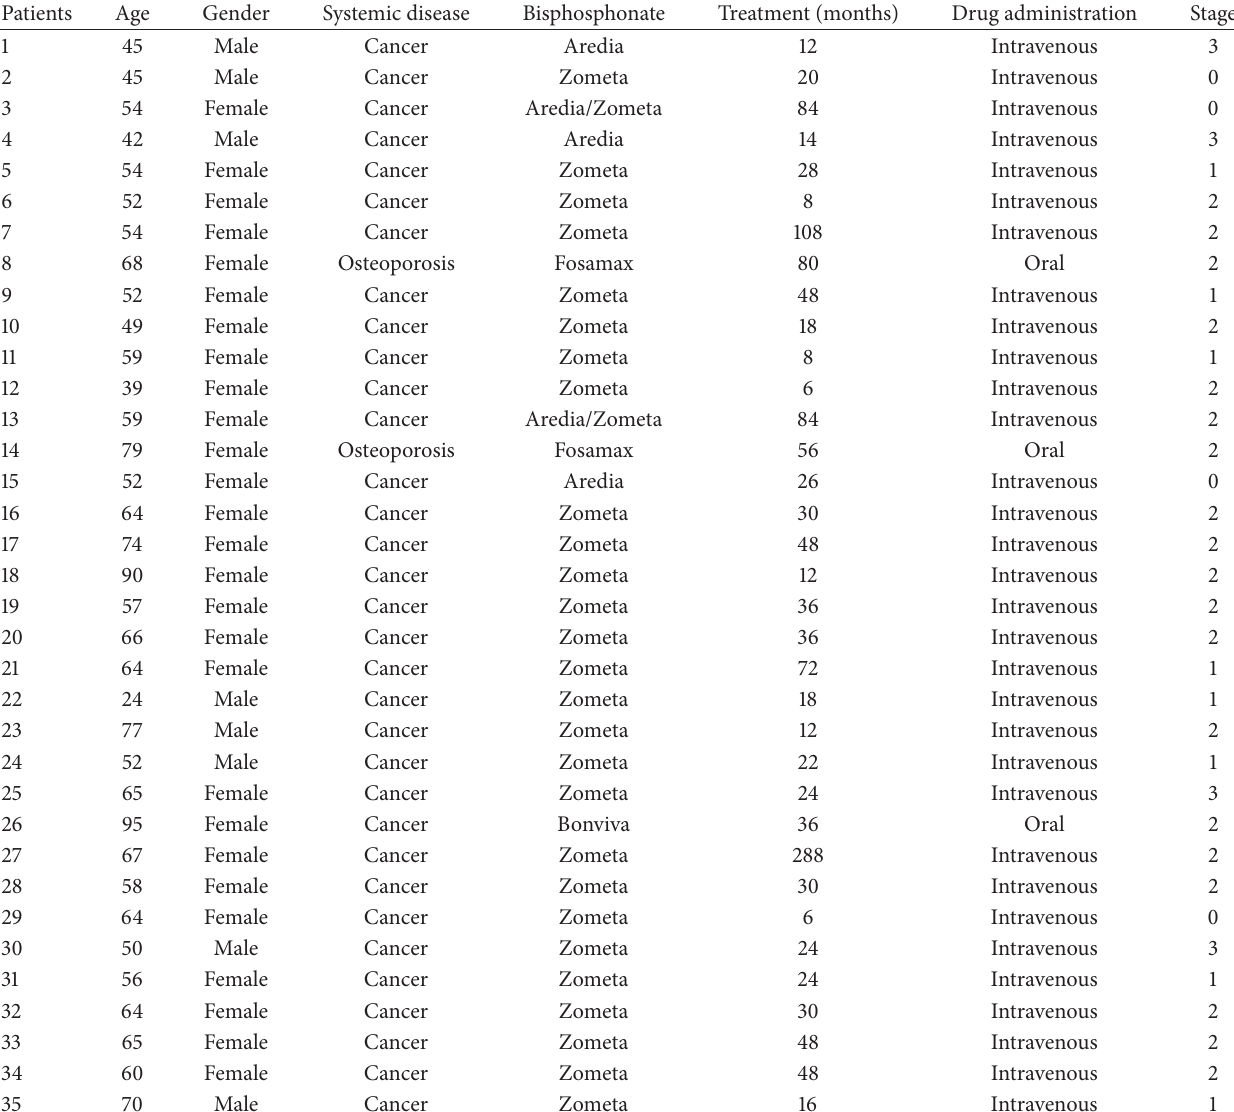
Table 1: Data of 35 patients with